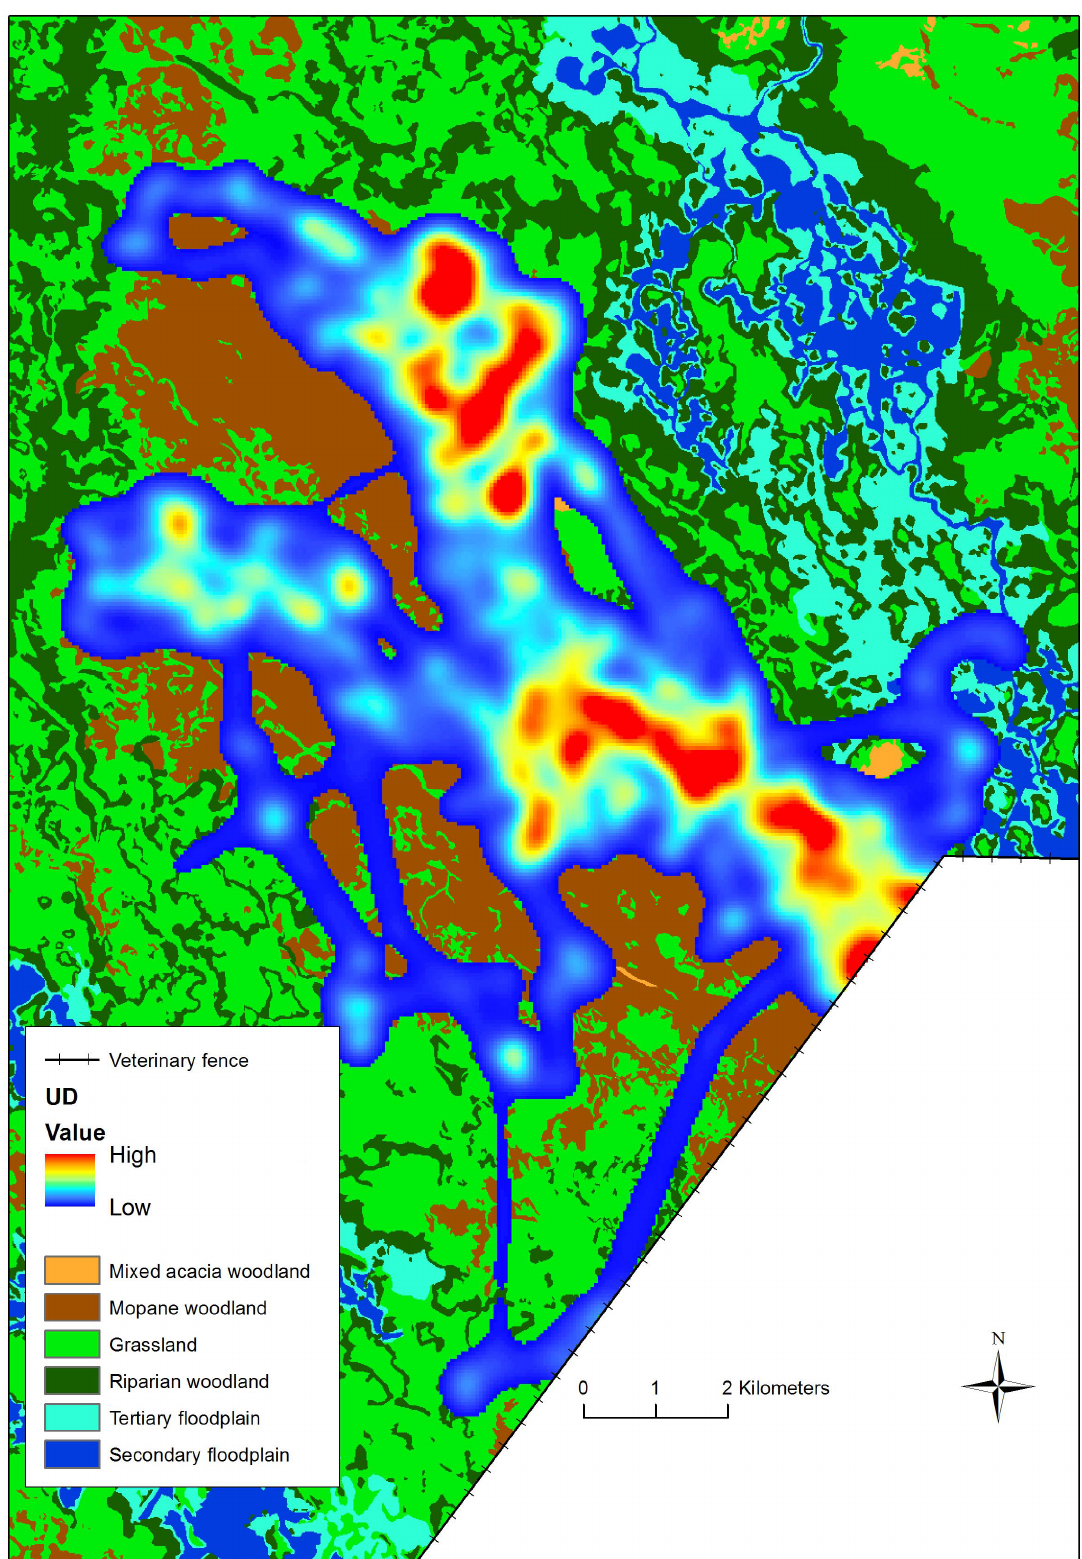
Figure 3. Example of a utilisation distribution produced using the Movement Density Kernel Estimation method. The figure is based on 1754 GPS fixes from one collared buffalo, B5, during the rainy season of 2009.